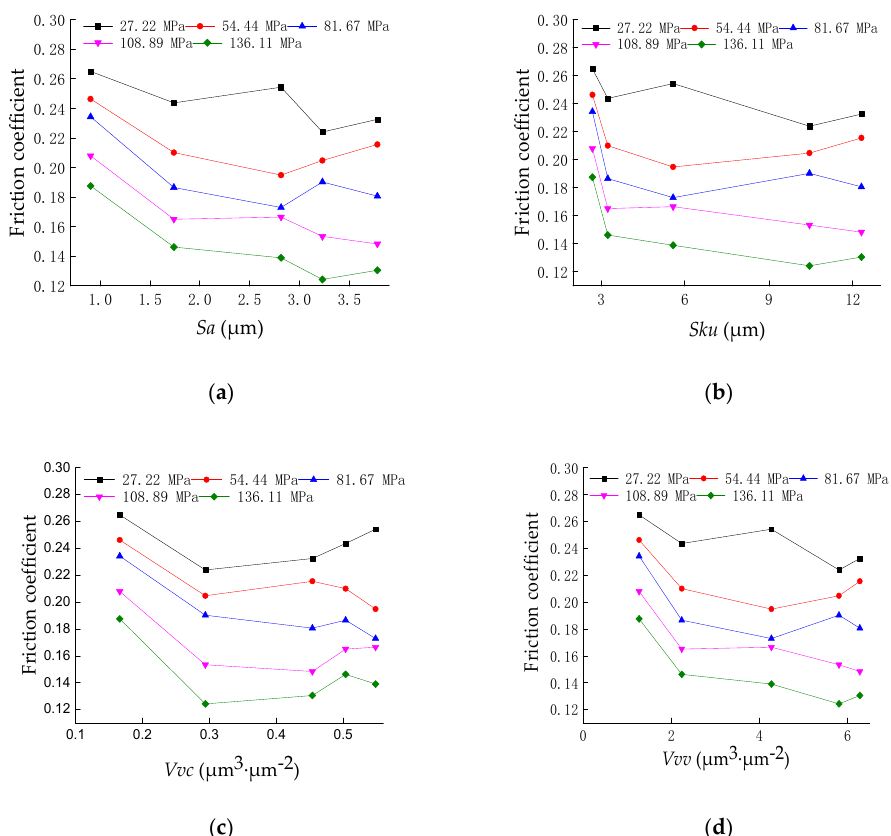
Figure 4. Friction coefficient as a function of 3D characterization parameters. ( a ) Friction coefficient a function of Sa ; ( b ) friction coe ffi cient as a function of Sku ; ( c ) friction coe ffi cient as a function of Vvv ; as a function of Sa ; ( b ) friction coefficient as a function of Sku ; ( c ) friction coefficient as a function of ( d ) friction coe ffi cient as a function of Vvc Vvv ; ( d ) friction coefficient as a function of Vvc.